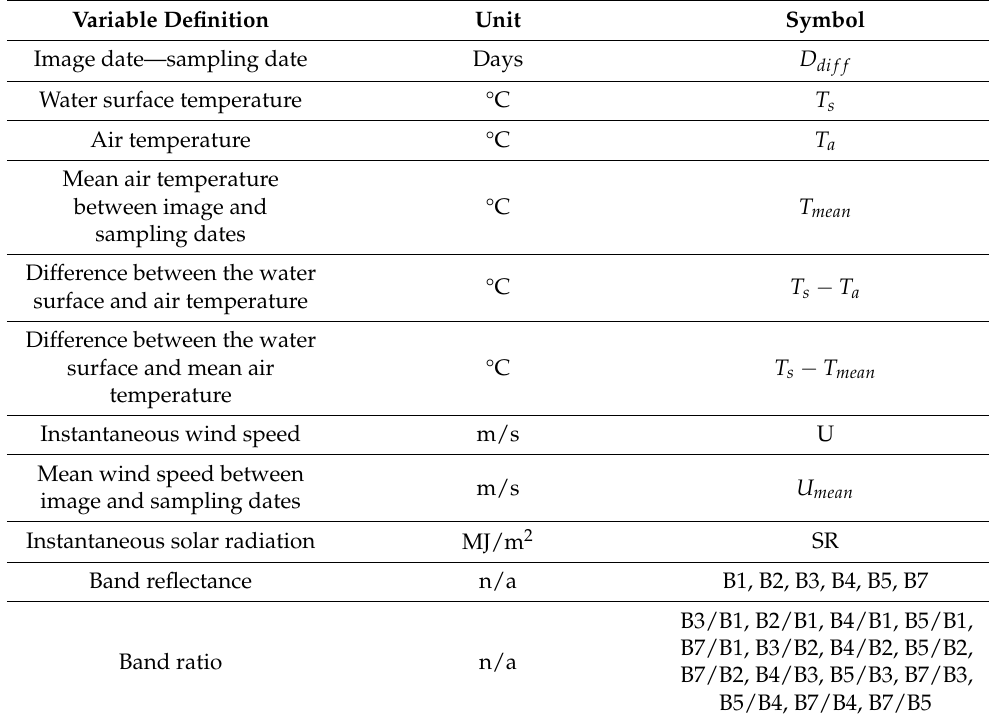
Table 2. List of predictor variables initially used in the variable selection